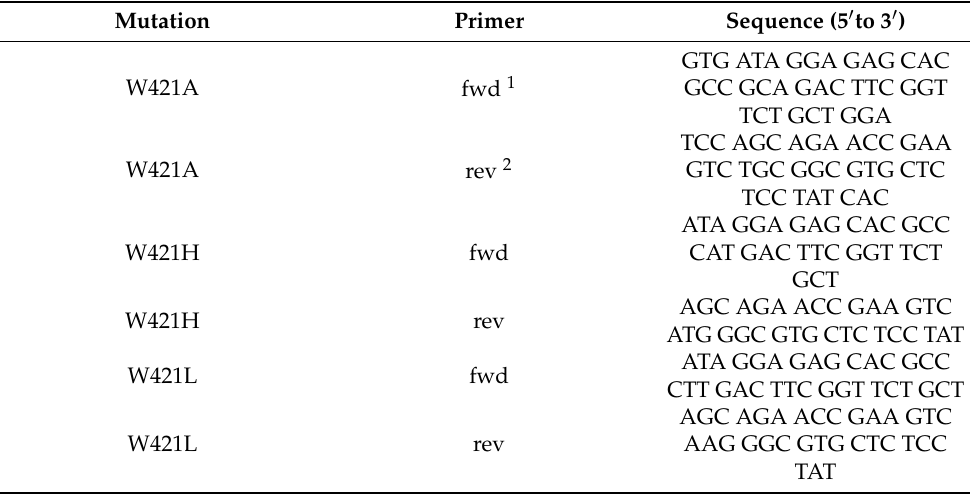
Table 2. Primers used for site-directed mutagenesis of the pSV-PE WT vector containing prM and E of TBEV Strain